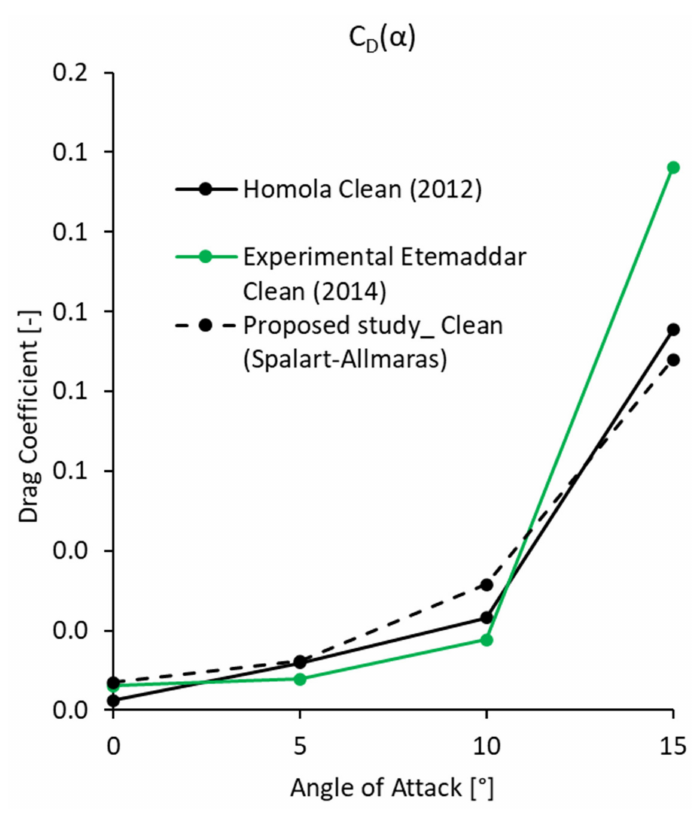
Figure 5. Drag coefficient for the clean airfoil compared with